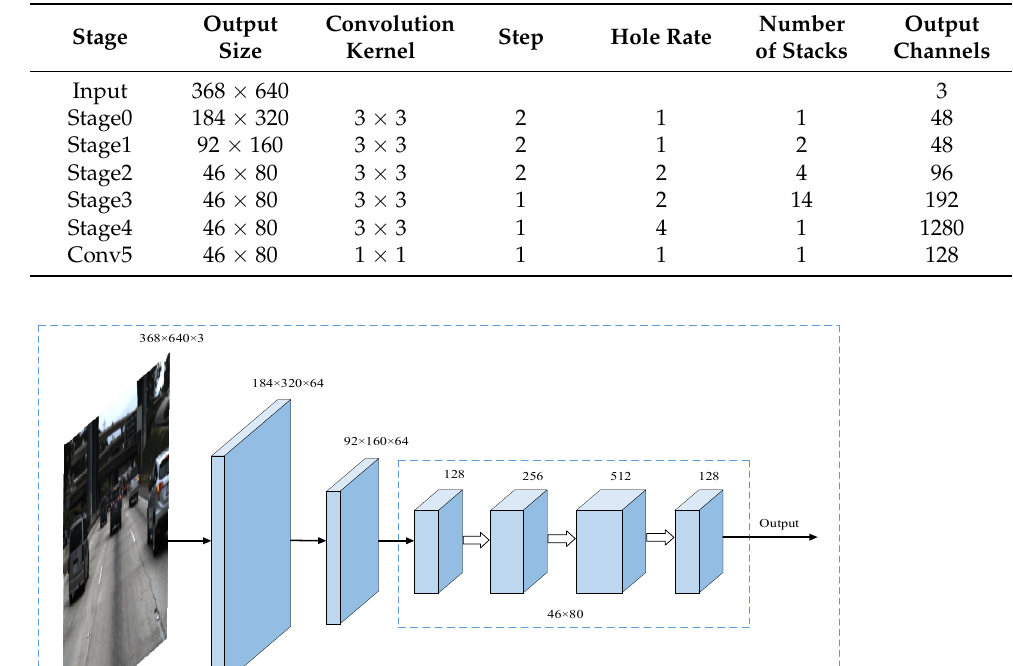
Table 1. Overall structure of the encoder.